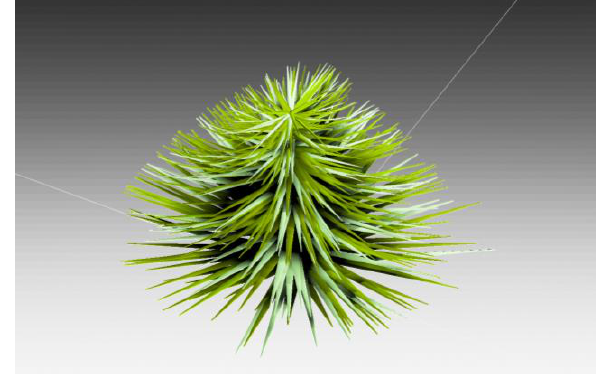
Figure 8. Black pine data from 3D point cloud